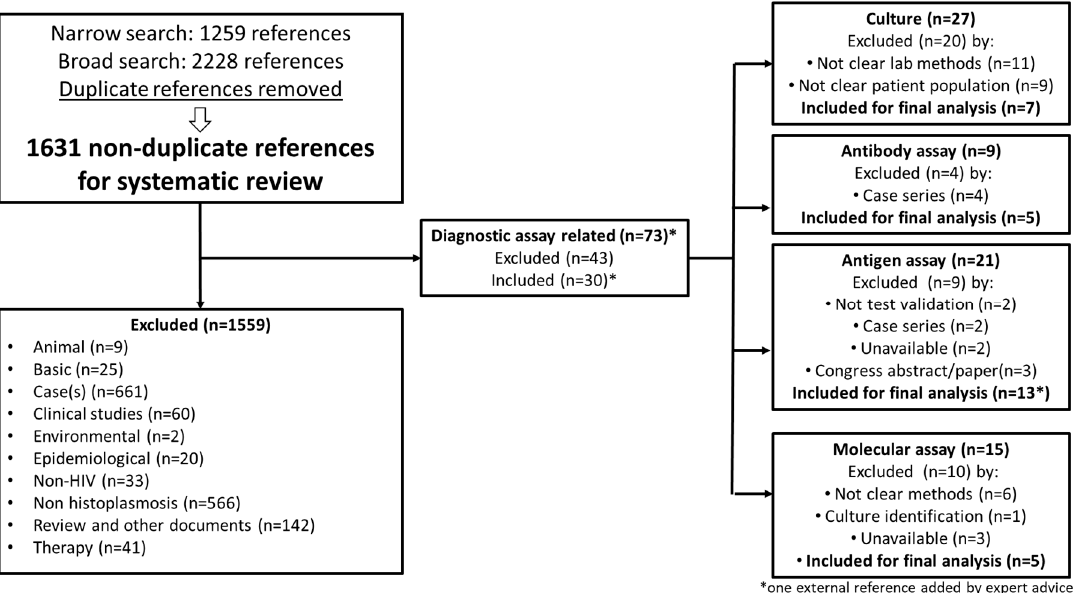
Figure 1. A flow chart of the literature search and studies selection.